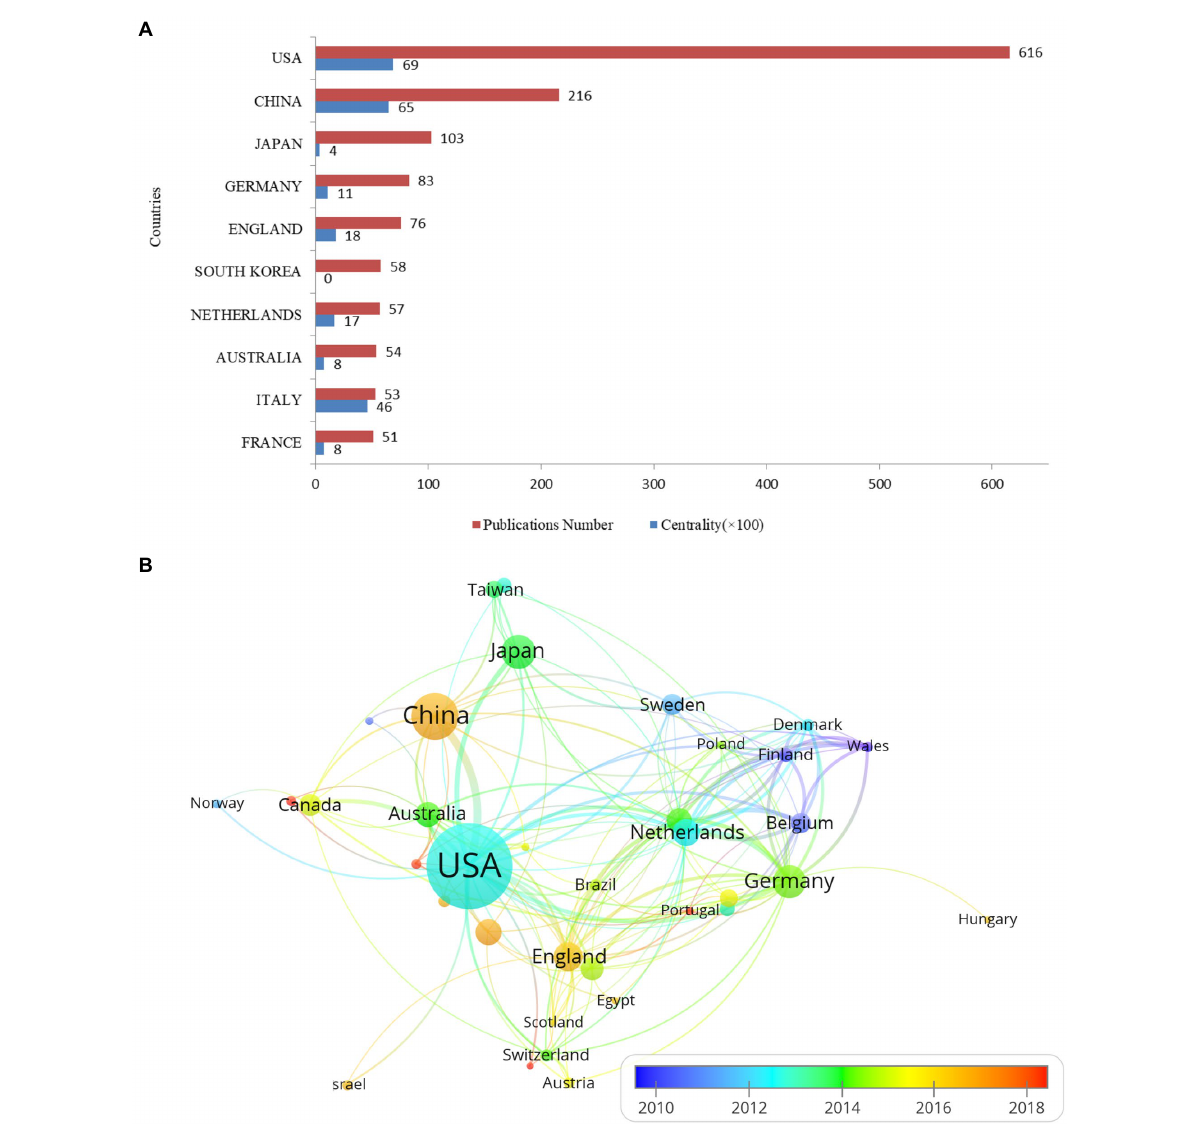
(AAY) for the country. The nodes given blue or green color